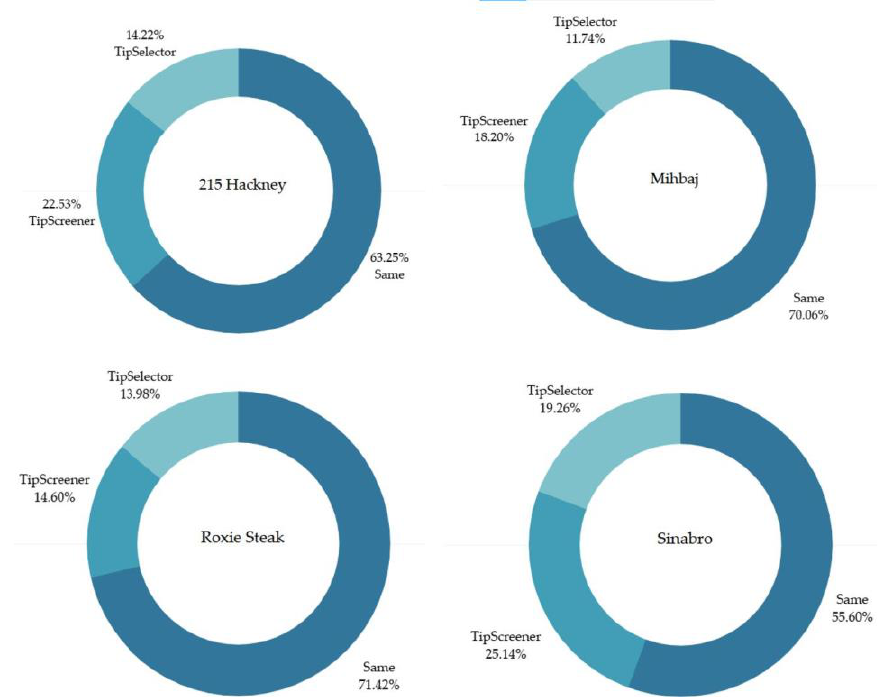
Figure 10. Informativeness of tips generated by the two algorithms.